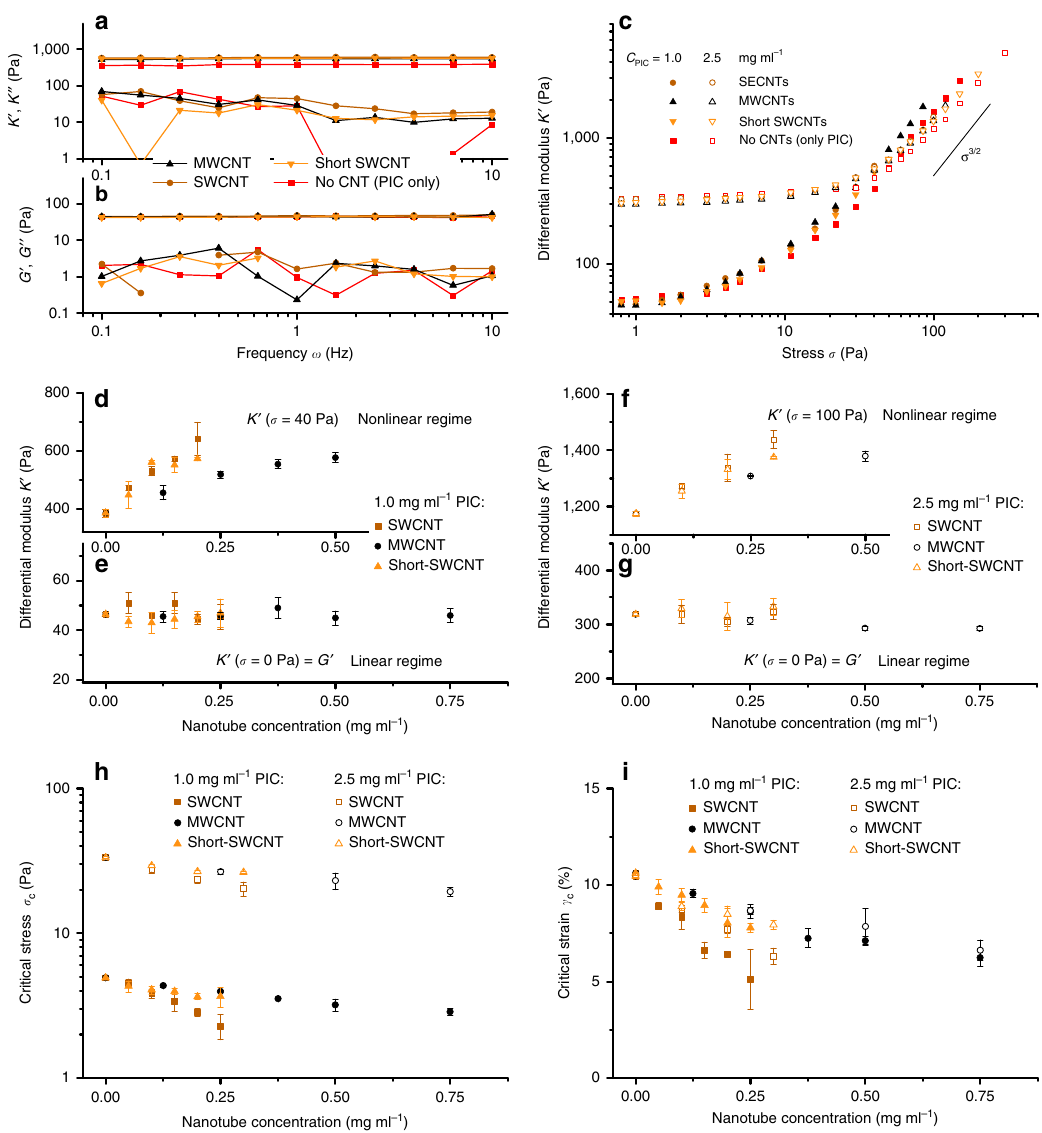
Figure 2 | Mechanical properties of composites with semi-flexible PIC networks and rigid CNT rods. ( a , b ) Frequency sweeps in the linear viscoelastic regime ( a ) and in the nonlinear regime at a pre-stress s 0 ¼ 40Pa ( b ). The colours are indicated in the legend; the concentrations: c PIC ¼ 1.0mgml (cid:2) 1 (all samples), c SWCNT ¼ 0.2mgml (cid:2) 1 , c MWCNT ¼ 0.5mgml (cid:2) 1 , c short-SWCNT ¼ 0.2mgml (cid:2) 1 . ( b ) Differential modulus at frequency o ¼ 1Hz at the same concentrations as in a , b . ( c – g ) Stiffness of PIC/CNTcomposites in the linear regime represented by the differential modulus K 0 at s ¼ 0Pa ( e , g ) and the nonlinear regime represented by K 0 at s ¼ 40Pa or s ¼ 100Pa ( d , f ) for gels with PIC concentrations of 1.0 ( d , e ) and 2.5mgml (cid:2) 1 ( f , g ), respectively. ( h ) The critical stress s c decreases with nanotube concentration for gels with PIC concentrations of 1.0 and 2.5mgml (cid:2) 1 . Note the logarithmic scale on the y axis. ( i ) The critical strain g c also decreases with increasing nanotube concentrations. The effects are strongest for the gels with long single-walled CNTs and low PIC concentrations. The error bars represent s.d.’s over two